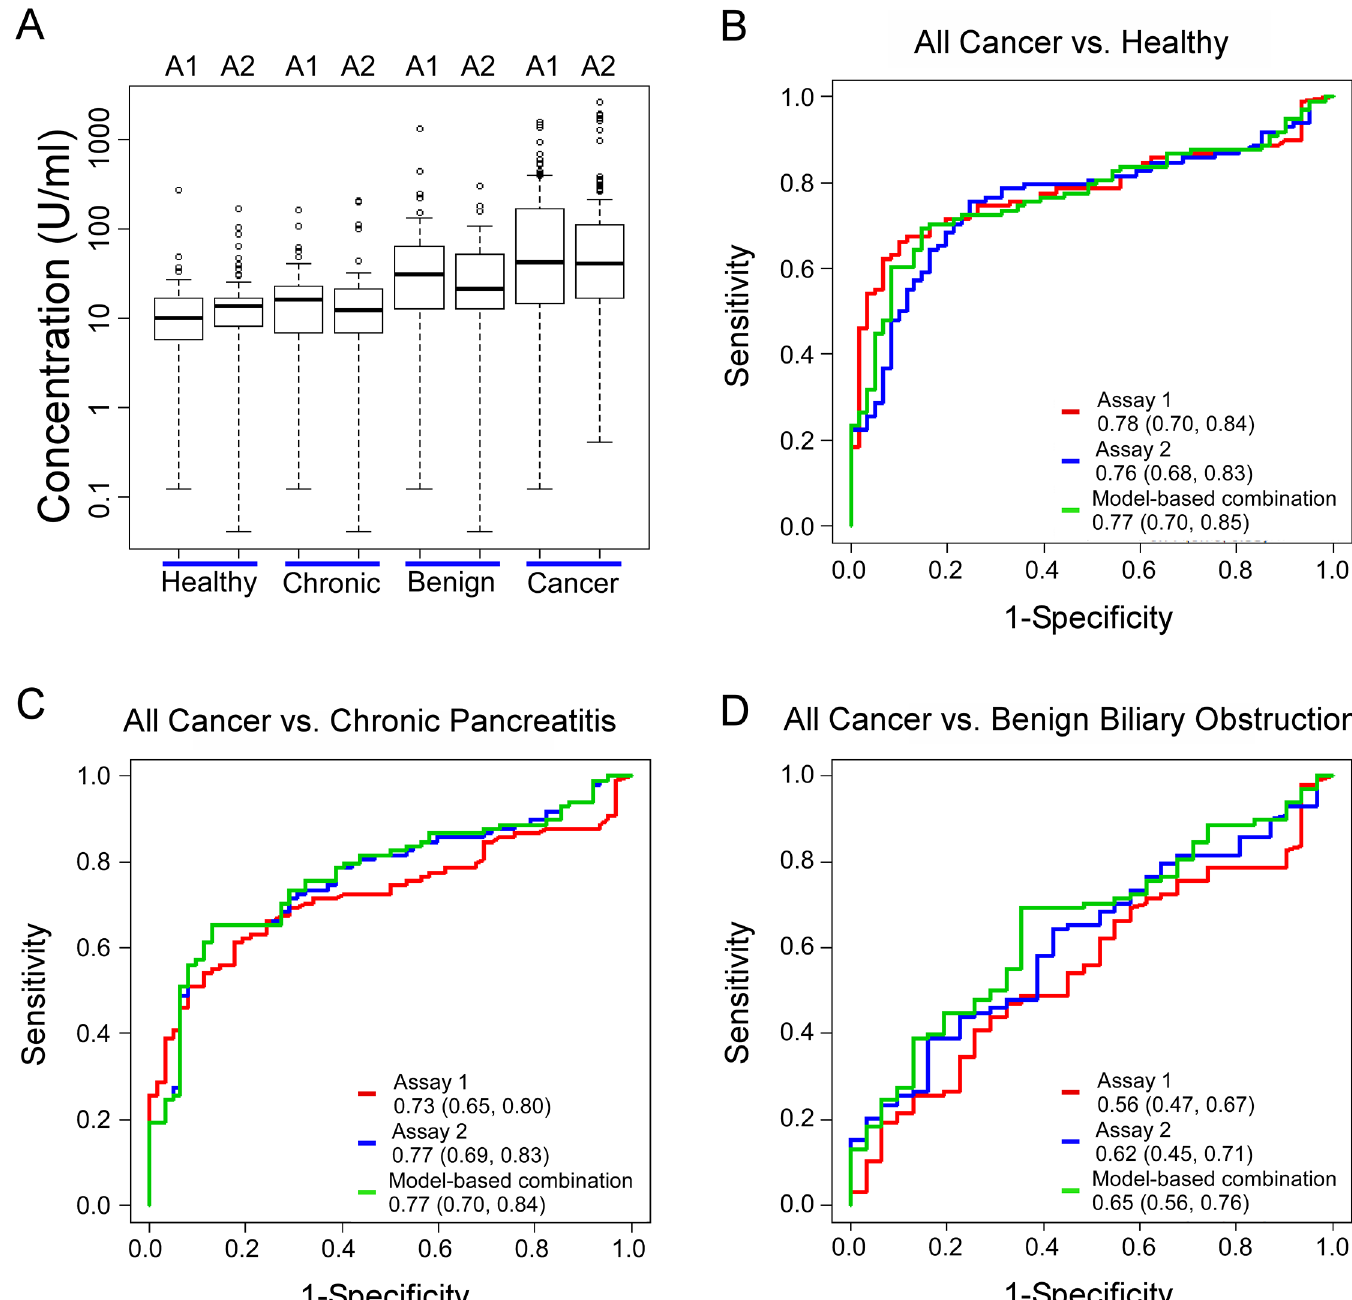
Fig 1. Differentiating pancreatic cancer from control subjects by two different CA 19 – 9 assays. A) CA 19 – 9 levels in each group. We present the log- transformed values to better visualize all ranges of the values. The boxes indicate the quartiles of the distributions, the horizontal lines in the boxes indicate the medians, and the dashed lines give the ranges, with individual outliers indicated by the circles. A1, Assay 1; A2, Assay 2. B-D) Receiver-operator- characteristic (ROC) curves comparing all pancreatic cancer patients to the indicated control groups. The legends specify the area-under-the-curves (AUCs) for each assay, with the ranges of the 95% confidence